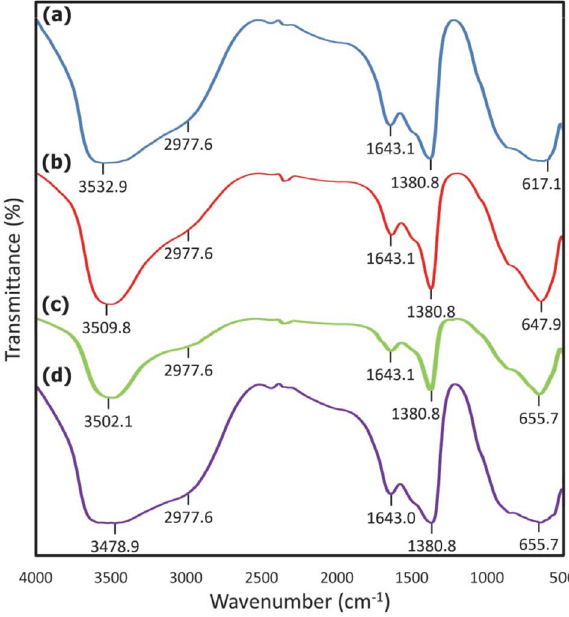
Figure 2. IR spectra of (a) Mg-Al-LDH, (b) CR-adsorbed Mg-Al- LDH, (c) Mg-Al-LDH modified with NaOH solution at pH = 10 and (d) Mg-Al-LDH modified with NaOH solution at pH =